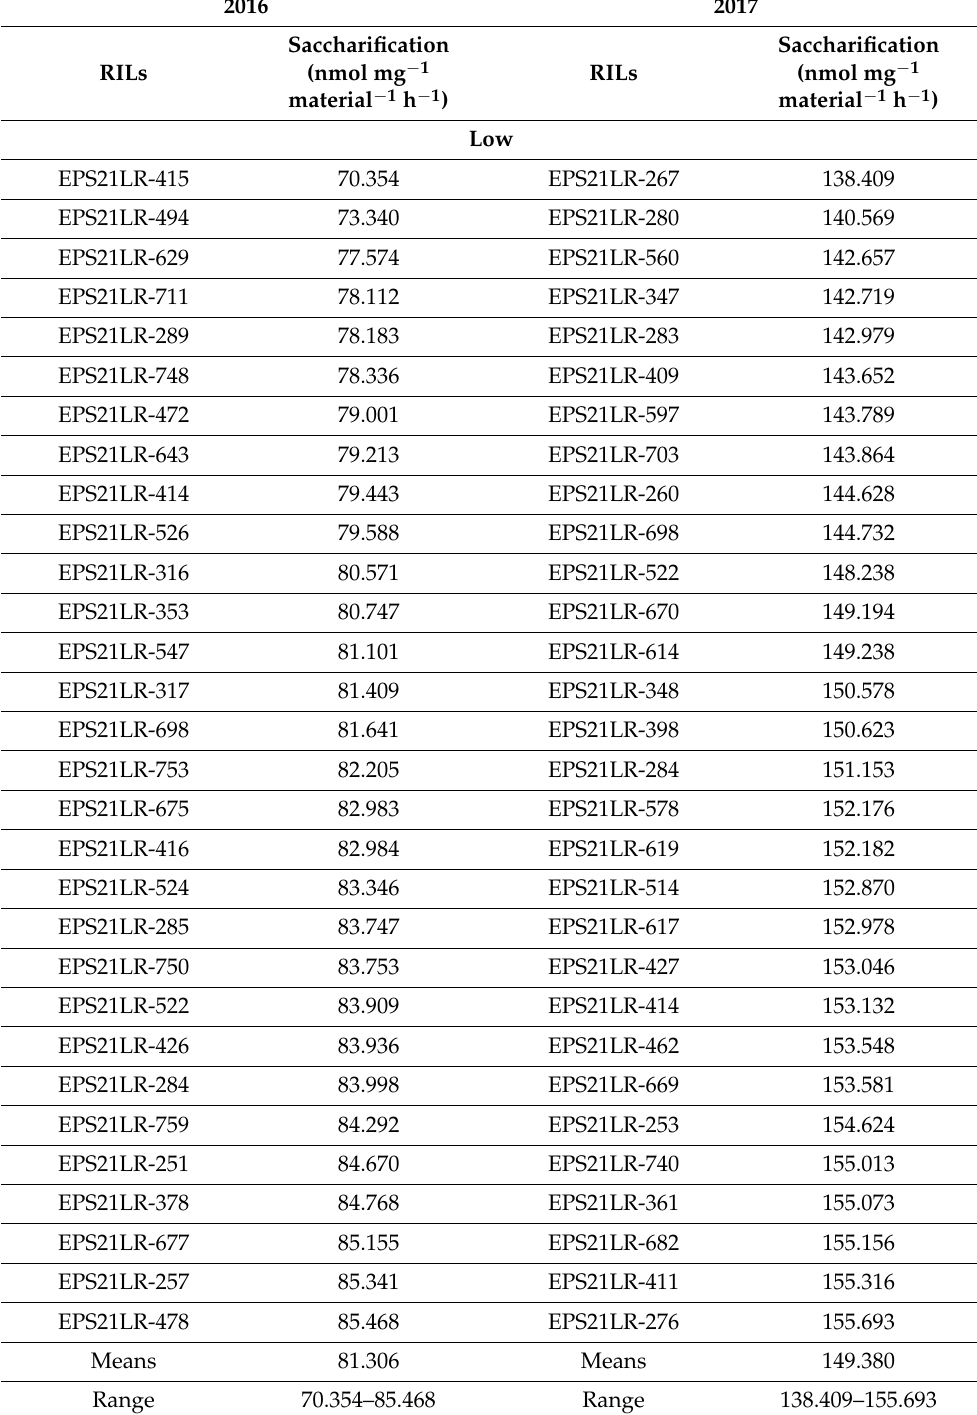
Table 1. Saccharification efficiency data, means, and range for two years (2016, 2017) in selected RILs from a MAGIC population classified in high and low saccharification